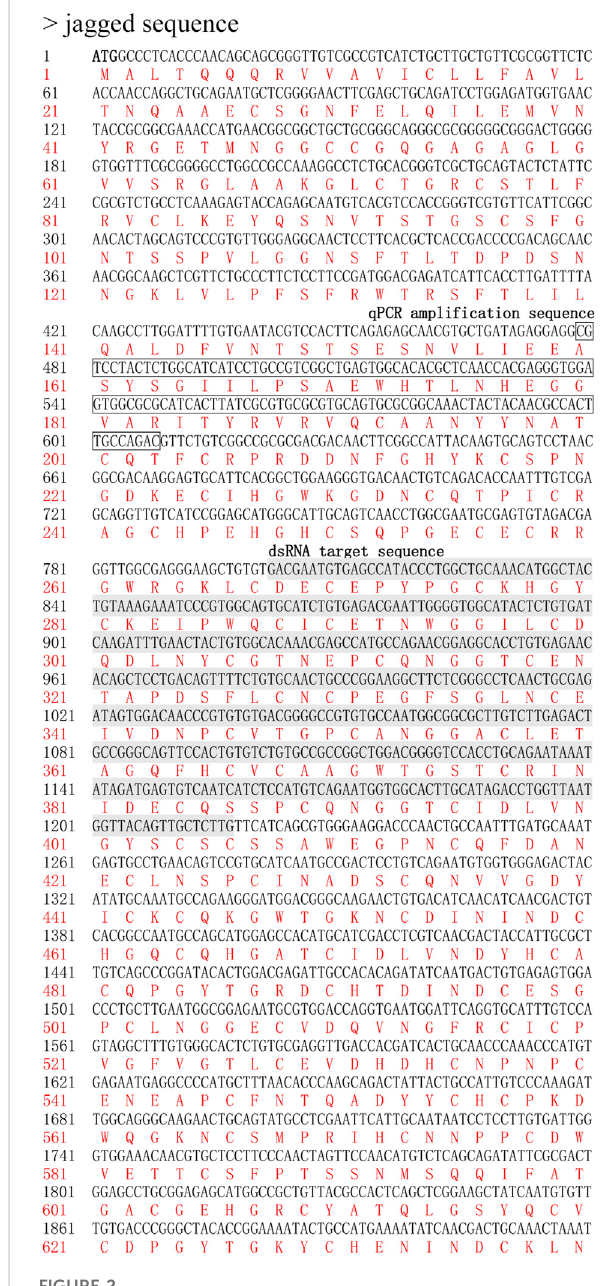
FIGURE 2 Nucleotide and deduced amino acid sequences of Nljagged . The target sequence of ds Nljagged is indicated in grey; the fragment ampli fi ed by qPCR is indicated by a